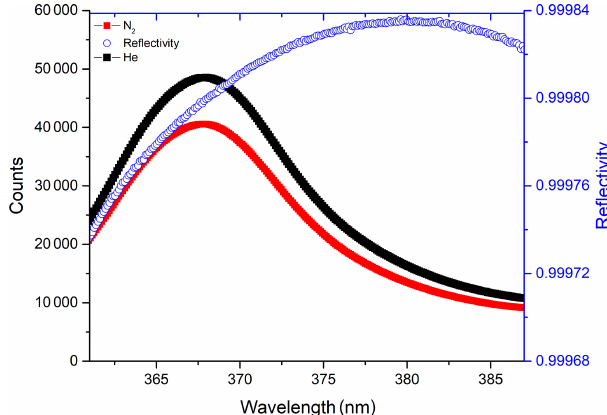
Figure 2. Dependences of the transmission intensity when the cav- ity is filled with N 2 and He gas respectively, and the calculated cav- ity mirror